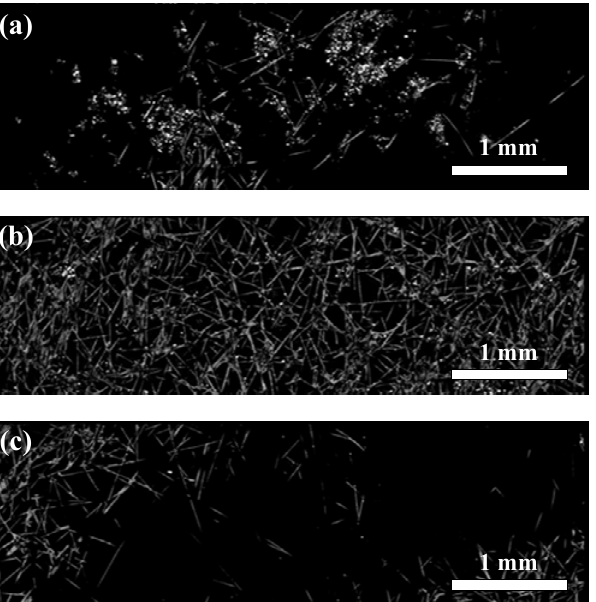
Figure 1. CT tomograms of composite electrode in different regions: ( a ) bottom region, ( b ) central region, and ( c ) upper region.